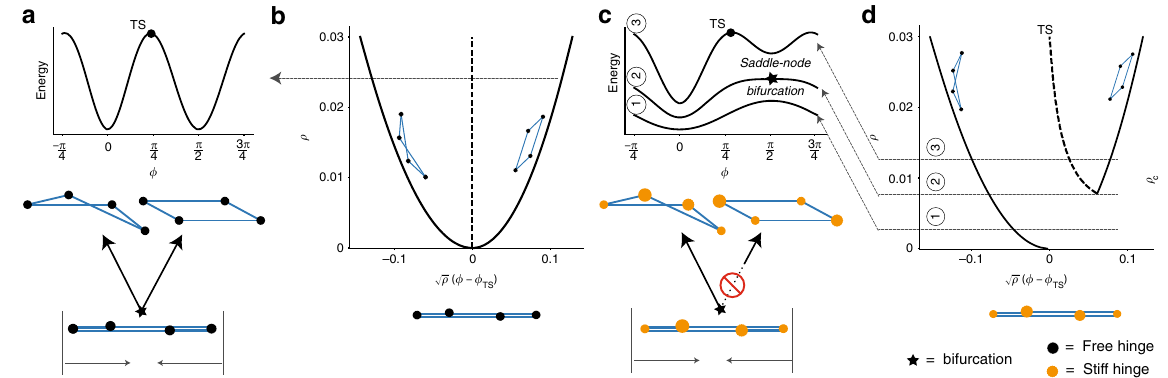
Fig. 1 Stiff joints in a linkage network can change the connectivity of nonlinear modes in state space. a , b The 4-bar linkage has only one degree of freedom, but two distinct zero energy motions that meet at a branch point at the fl at state, making the mechanism dif fi cult to control. The two motions can be seen as minima in the energy landscape at a fi xed total strain ρ . c , d We can eliminate a chosen motion in a saddle-node bifurcation at ρ c by making the joints stiff to different extents (i.e., adding torsional springs that are relaxed in the fl at state; larger orange circles denote stiffer springs). The bifurcation diagram shows that such a stiffness pro fi le changes the connectivity of the two nonlinear modes. One of the two modes is destroyed in a saddle-node bifurcation at ρ c and is thus inaccessible from the fl at state ρ = 0 ( ϕ — angle variable in the two-dimensional linearized null space at the fl at state, see Supplementary Note 1)